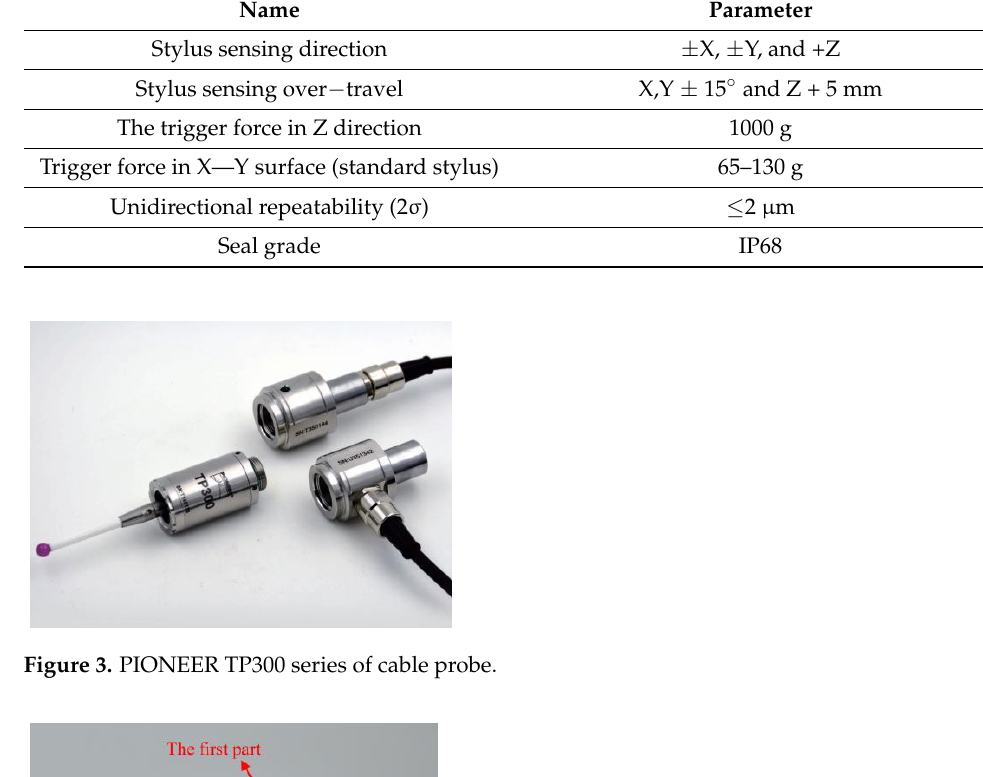
Figure 5. Electrical interface of Elfin 10 robot electrical box.